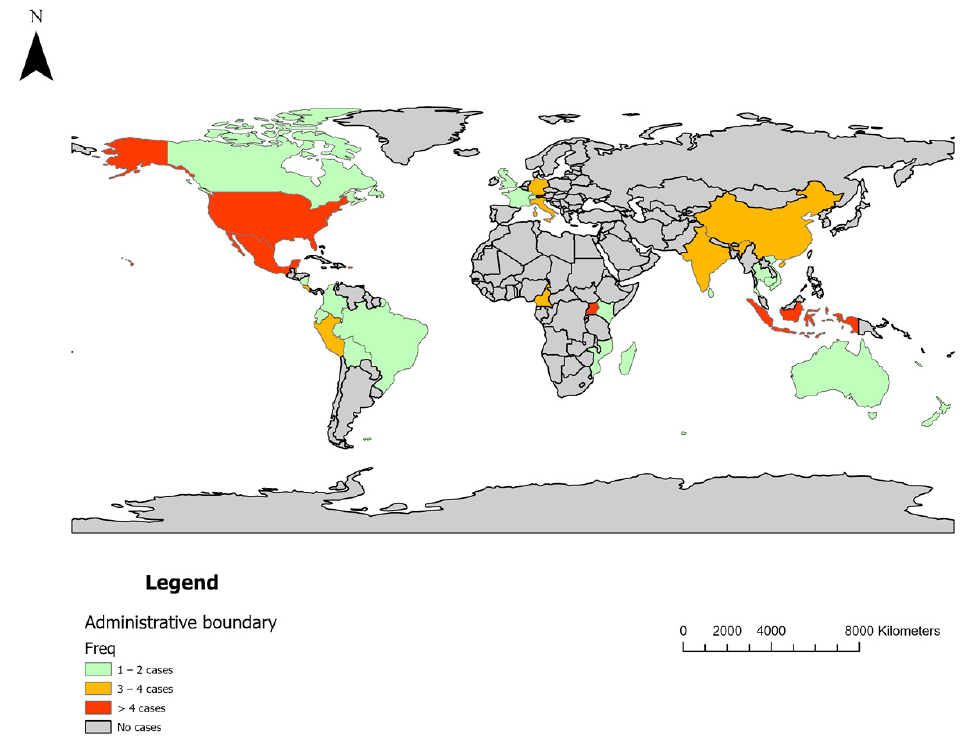
Figure 2. Geographical distribution of mechanisms reviewed (international mechanisms are ex- cluded).